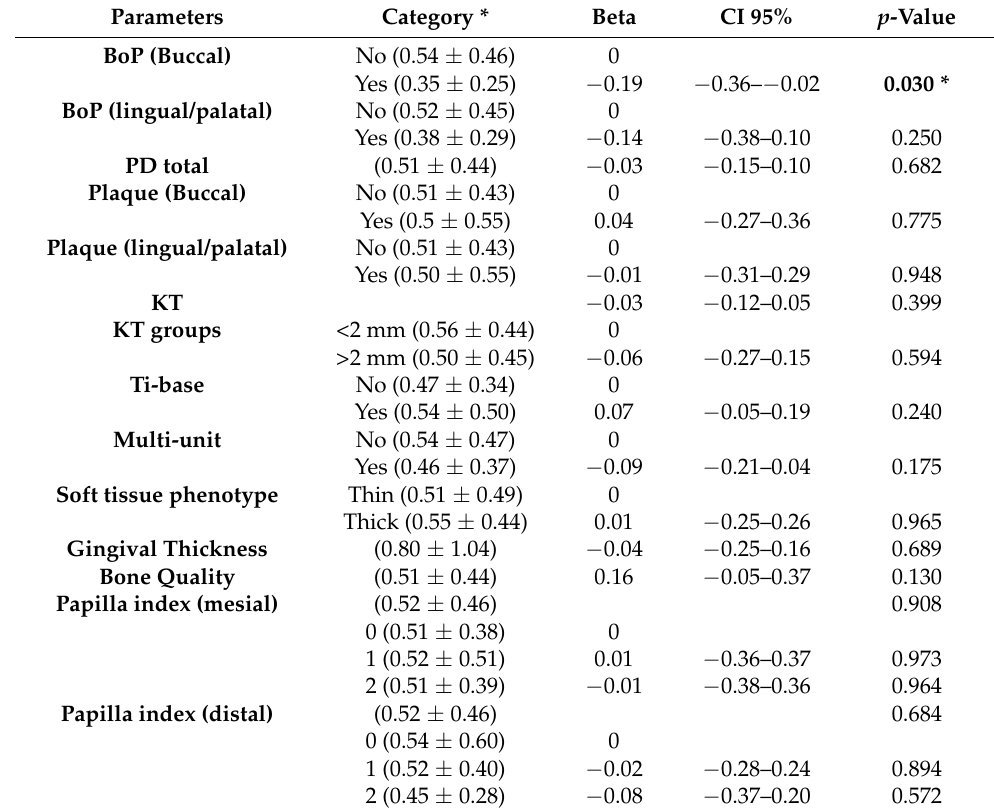
Table 5. Association between MBL and other clinical